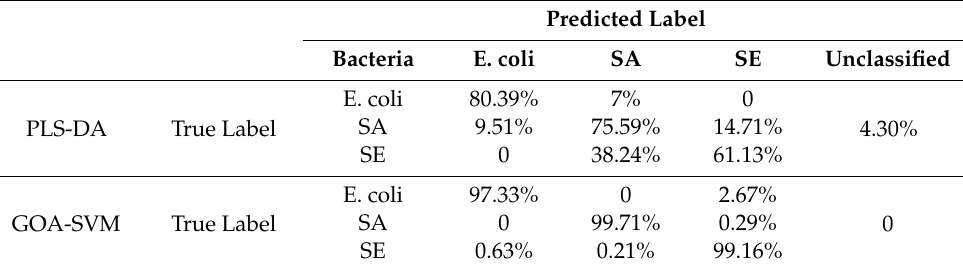
Table 2. Confusion matrix of prediction for full-wavelength models.